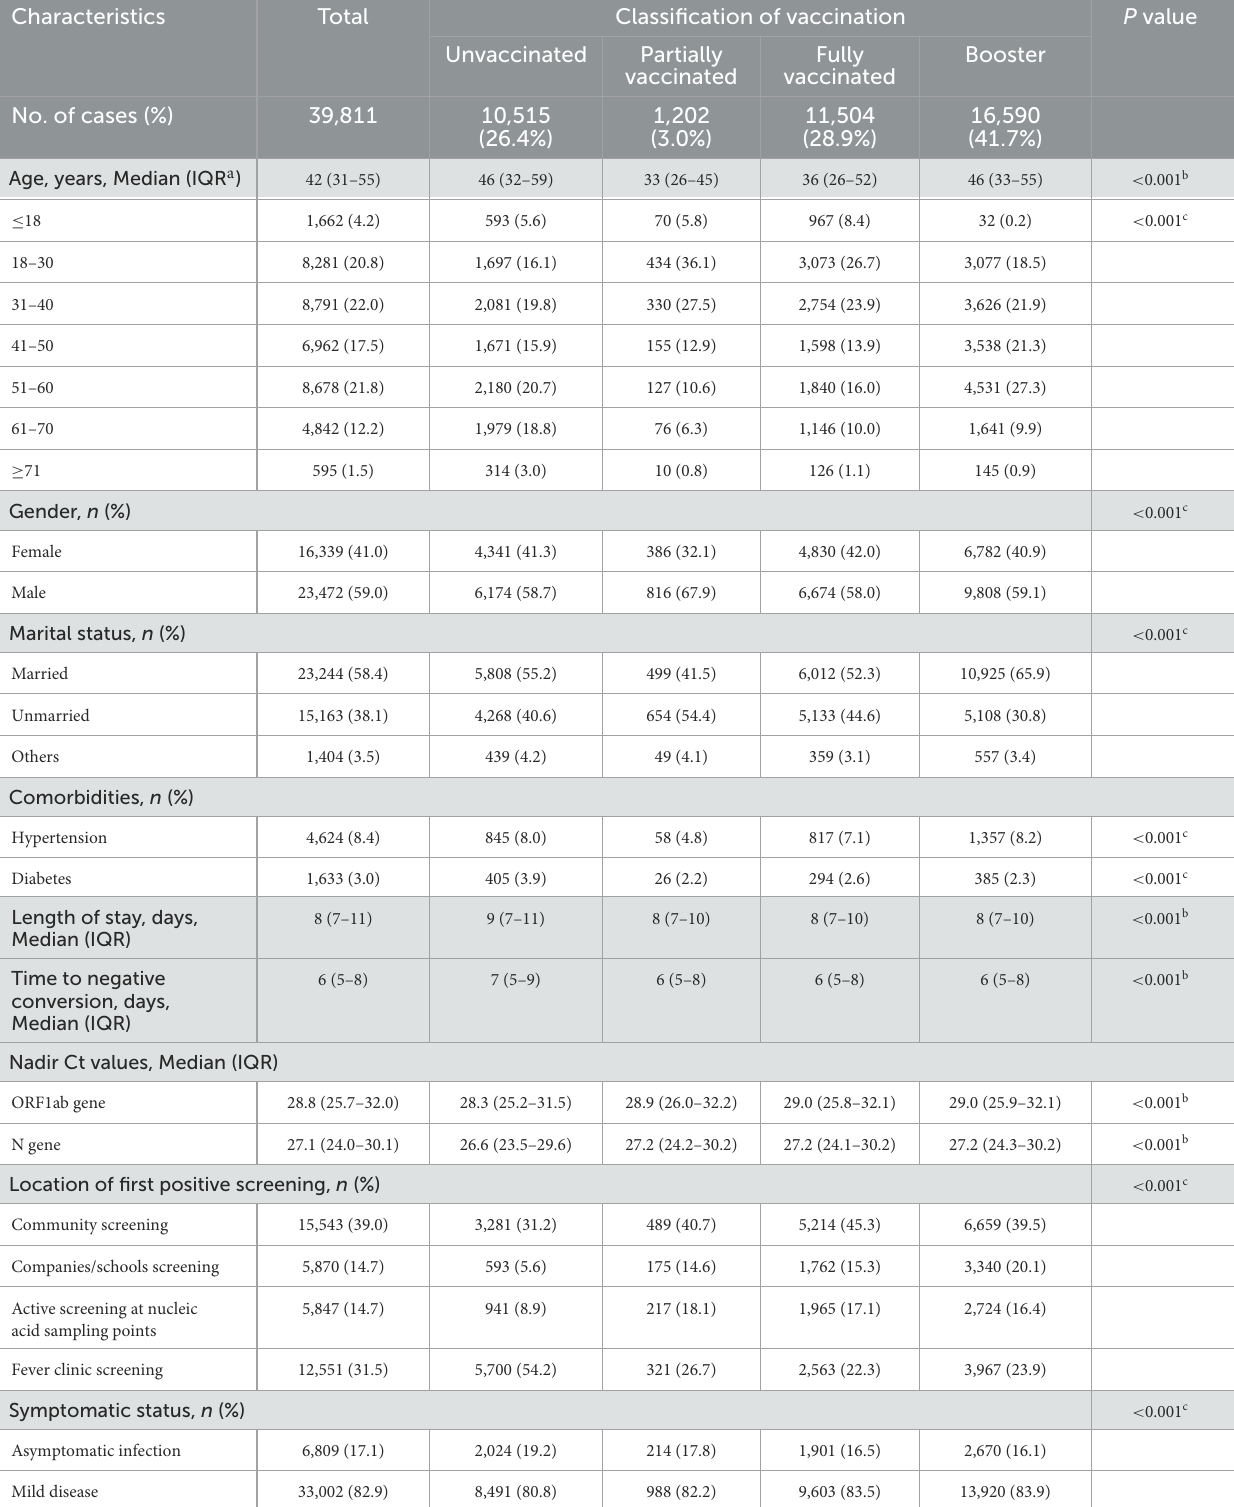
TABLE 1 Characteristics of individuals infected with Omicron classified by type of vaccination. Characteristics Total Classification of vaccination P value Unvaccinated Partially Fully vaccinated